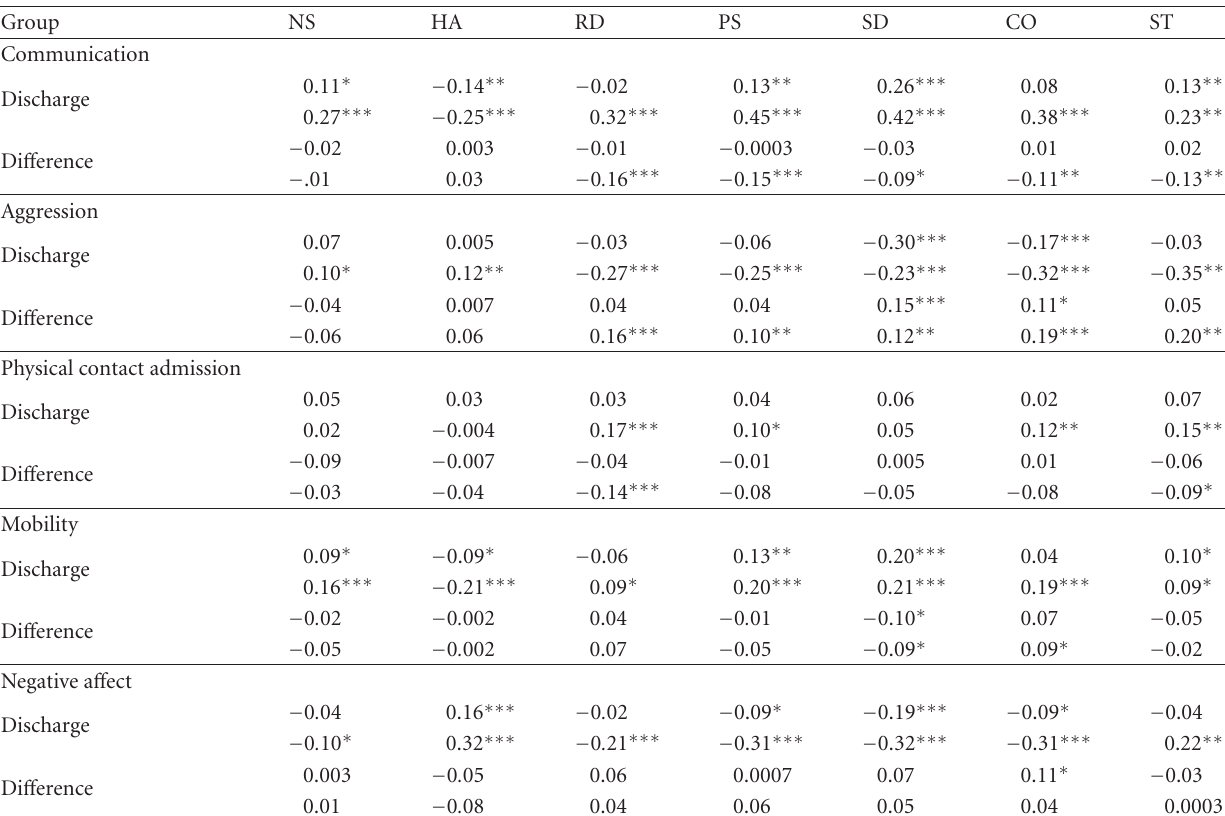
Table 4: Partial correlation coe ffi cients between personality (TCI interview—first row; TCI visual analogue scales—second row) and quality- of-life variables (controlled for age and